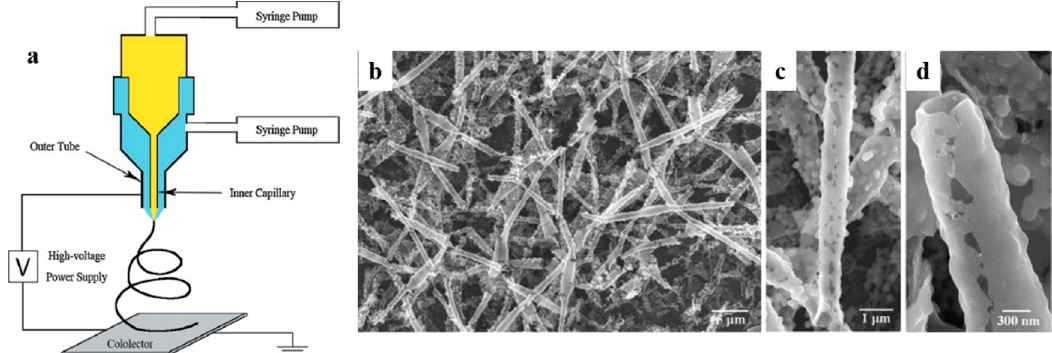
Figure 2. ( a ) A schematic of the coaxial electrospinning process for the fabrication of core-sheath TiO 2 nanofibers; SEM images of the core-sheath, then hollow TiO 2 nanofibers (TiO 2 /PVP composite nanofibers were coaxially electrospun with a PVP core solution and a titanium precursor as the shell solution, then calcined at 550 °C for 3 h); ( b ) a low magnification image of the as-synthesized hollow TiO 2 nanofibrous mat; ( c ) a high magnification image of the TiO 2 nanofibers; and ( d ) a high magnification image of the cross section of the hollow TiO 2 nanofiber (Reproduced with permission from [47]. Elsevier, 2017).